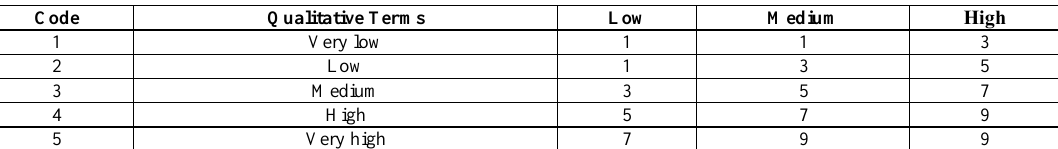
Table 8. Fuzzy scale.